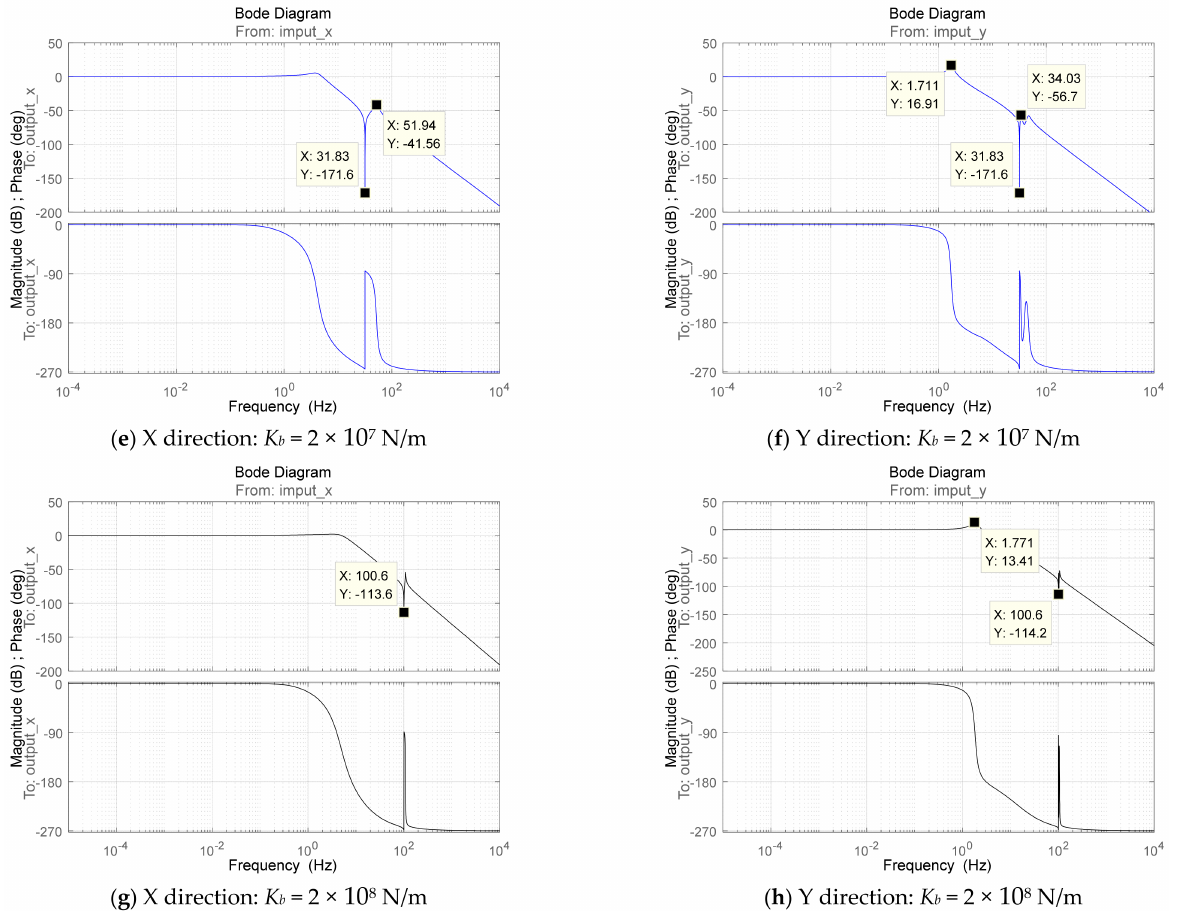
Figure 6. Effect of flexible base on frequency characteristics of control